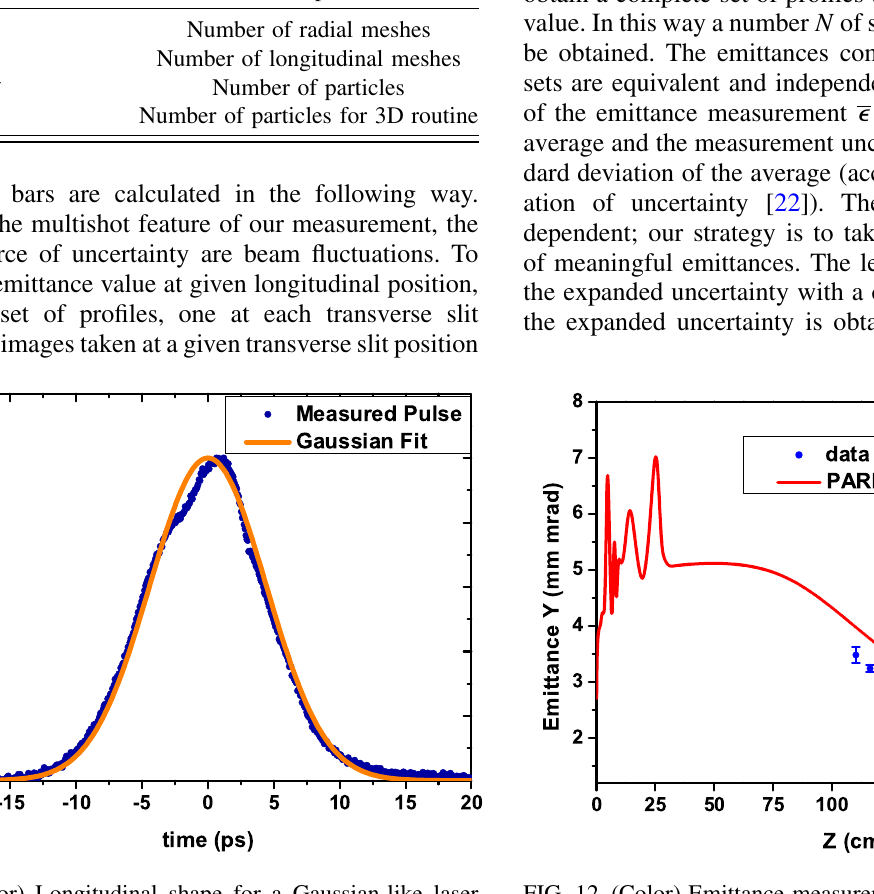
FIG. 11. (Color) Longitudinal shape for a Gaussian-like laser pulse obtained from a spectral measurement as described in Sec. II A compared with an ideal Gaussian.